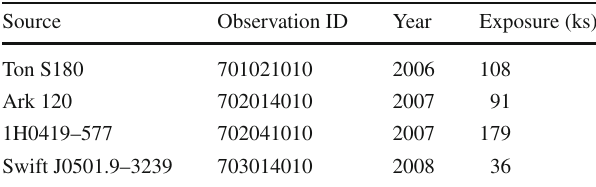
Table 1 Sources and Suzakuobservations analyzed in our